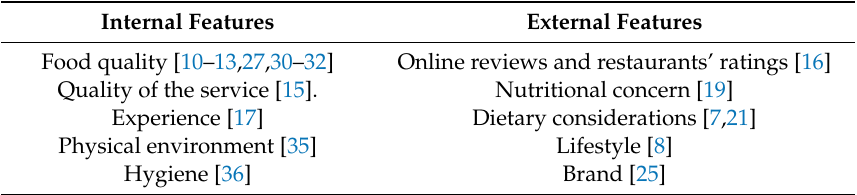
Table 1. Internal and external factors a ff ecting restaurant